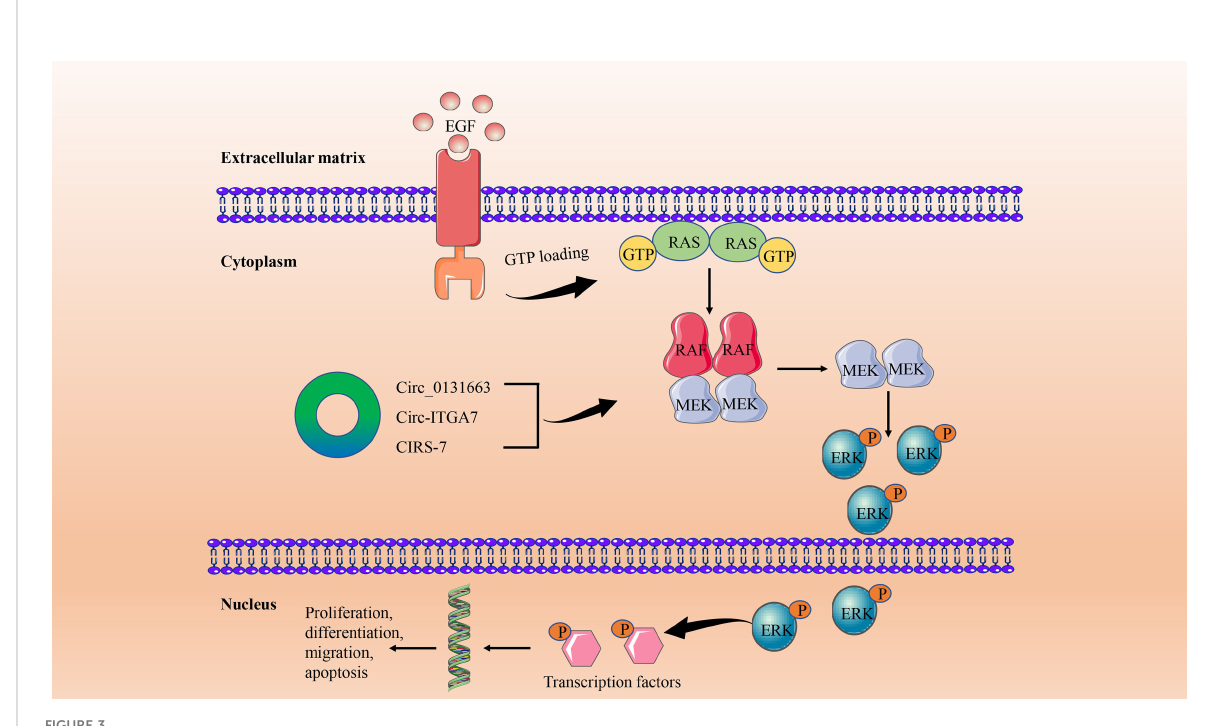
FIGURE 3 The circRNA/PI3K/AKT signaling axis in CRC. PI3K consists of a catalytic (P110) domain and a regulatory (P85) domain. PI3K is activated by a variety of growth factors and signaling complexes. Activated PI3K promotes PIP2 phosphorylation to produce PIP3, which activates PDK1. AKT is then phosphorylated at Thr308 of PDK1. Ultimately, AKT induces cell proliferation, differentiation, migration, and angiogenesis by mediating multiple signaling pathways such as mTOR, GSK-3 b , P53, CREB, P27, and NF- k